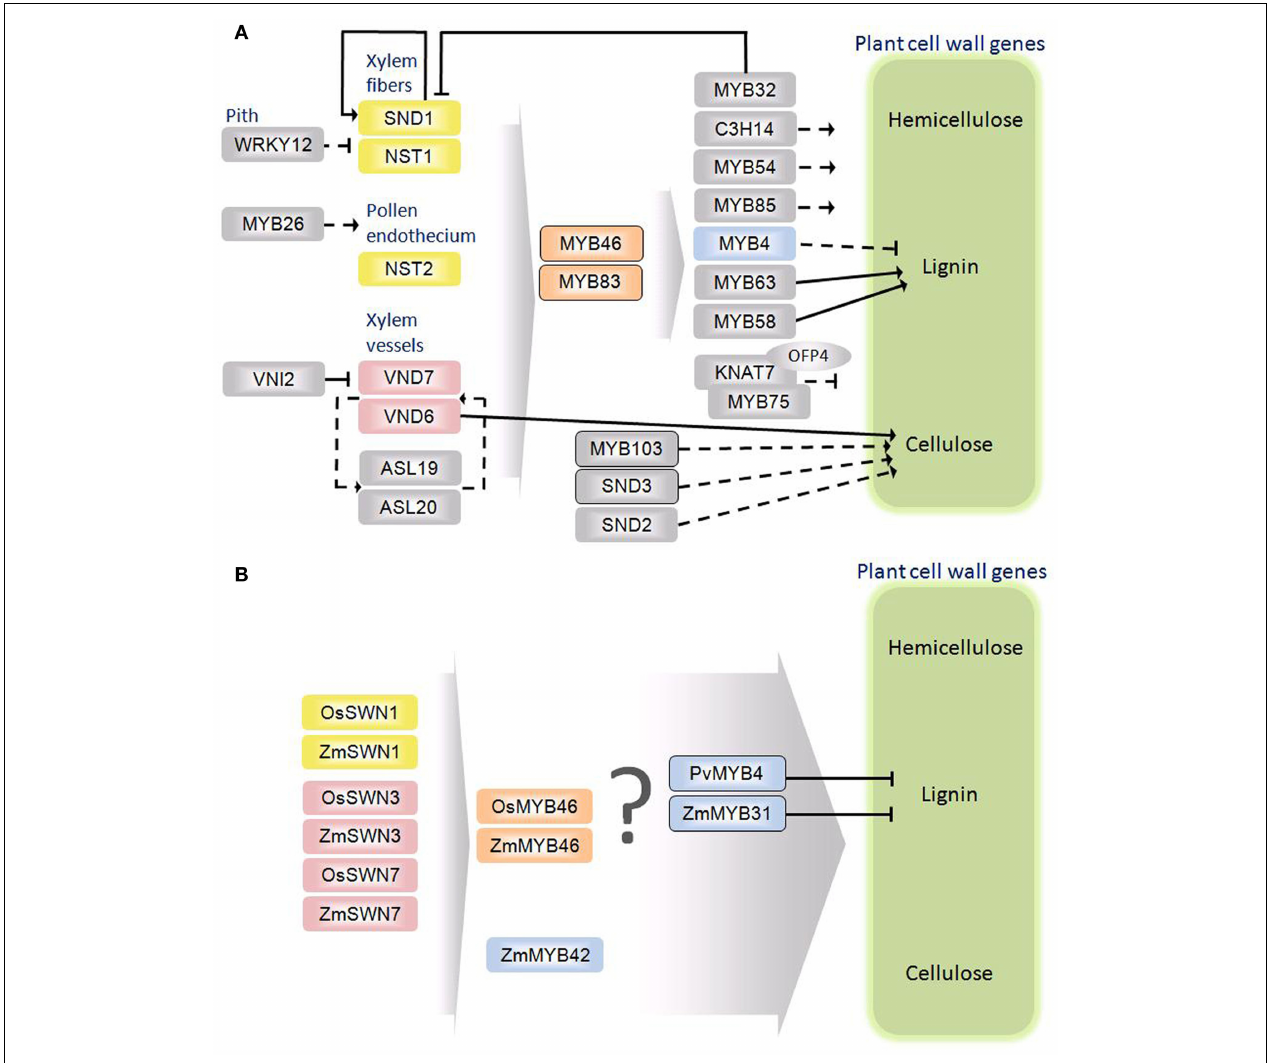
arrows and bordered rectangles signify evidence for direct interactions. Dashed arrows indicate no evidence for direct interaction. Orthology between A. thaliana and grasses is denoted by